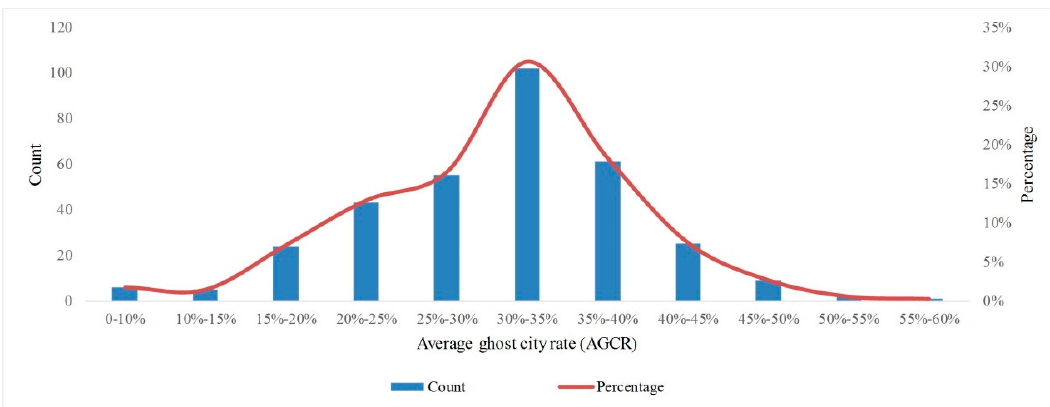
Figure 6. Normal distribution of municipal AGCRs.